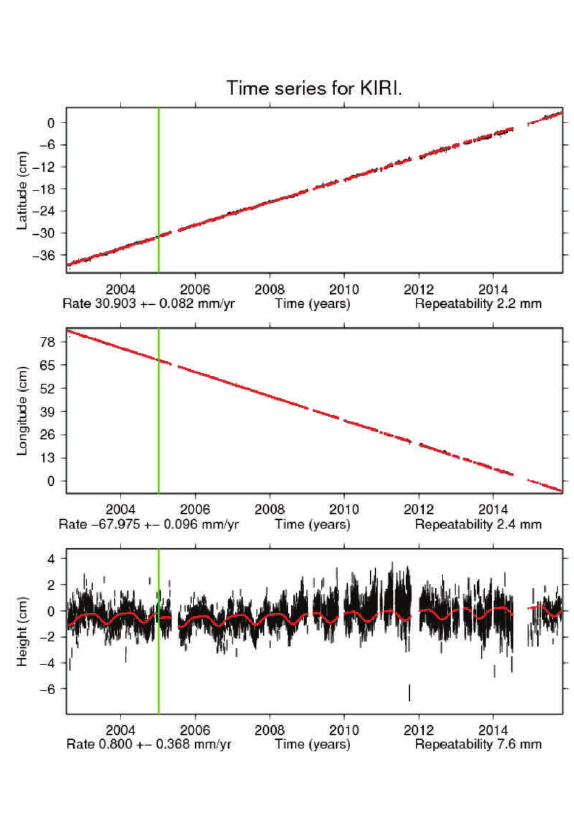
Fig. 8: Vertical position of the KIRI GPS dome according to the Jet propulsion Lab (image from